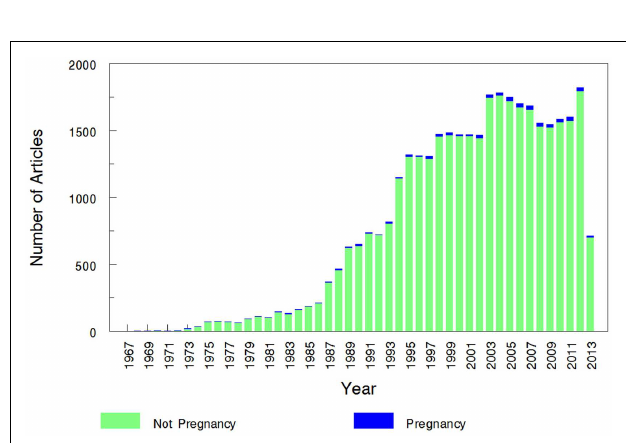
FIGURE 2 | Number of pregnancy and non-pregnancy pharmacokinetic clinical trials .The year 2013 includes those articles index for MEDLINE by August 31, 2013 only.This figure displays the number of pregnancy pharmacokinetic articles along with all pharmacokinetic articles (pregnancy search term excluded) found to otherwise match the search terms specified.